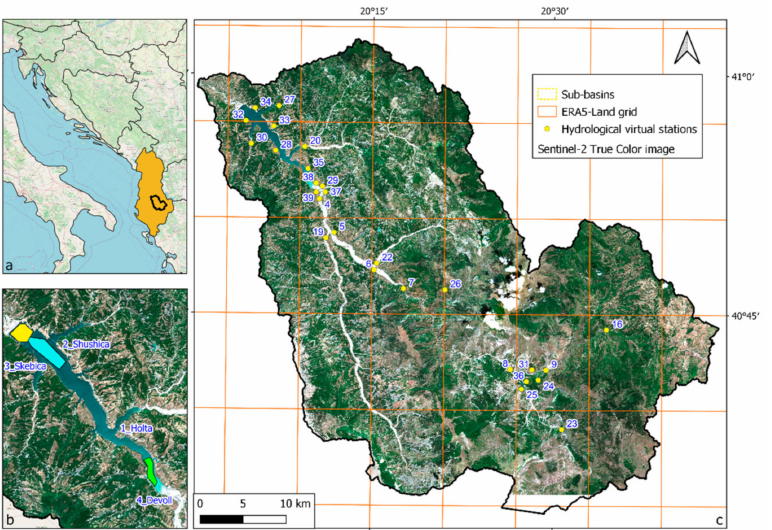
Figure 1. The Banja watershed, its location ( a ), and overview of the Banja reservoir ( b ). ( c ) The ERA5-Land grid is superimposed with orange lines, while numbered points indicate the virtual stations where the hydrological parameters are derived. ( b ) The cyan polygon is the central virtual station chosen as representative for the reservoir, while yellow and green polygons are used for spatial analysis and correspond to dam and inflow locations respectively. The names of the main inflows are numbered and shown in ( b